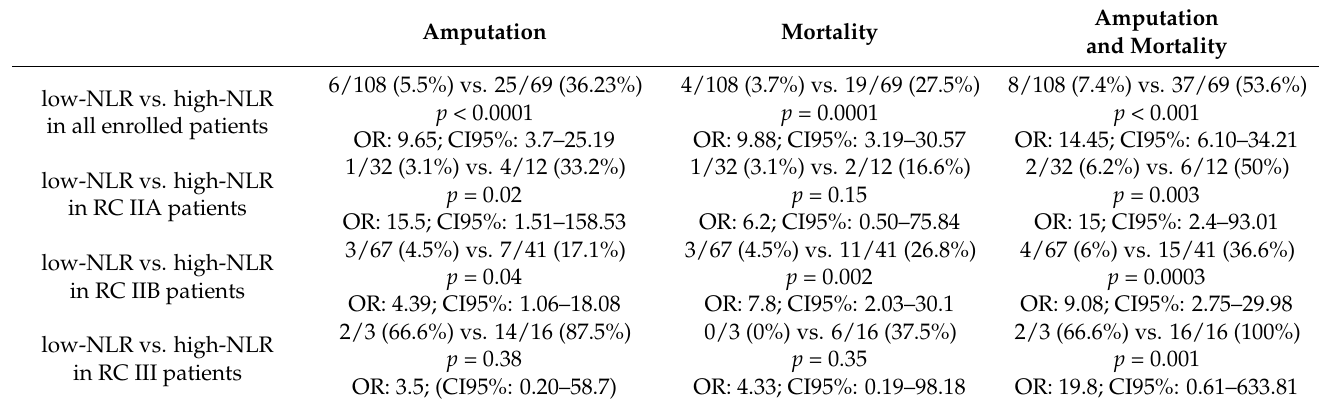
Table 2. Univariate analysis on RC and NLR at presentation and new adverse event occurrence during the study period. Amputation